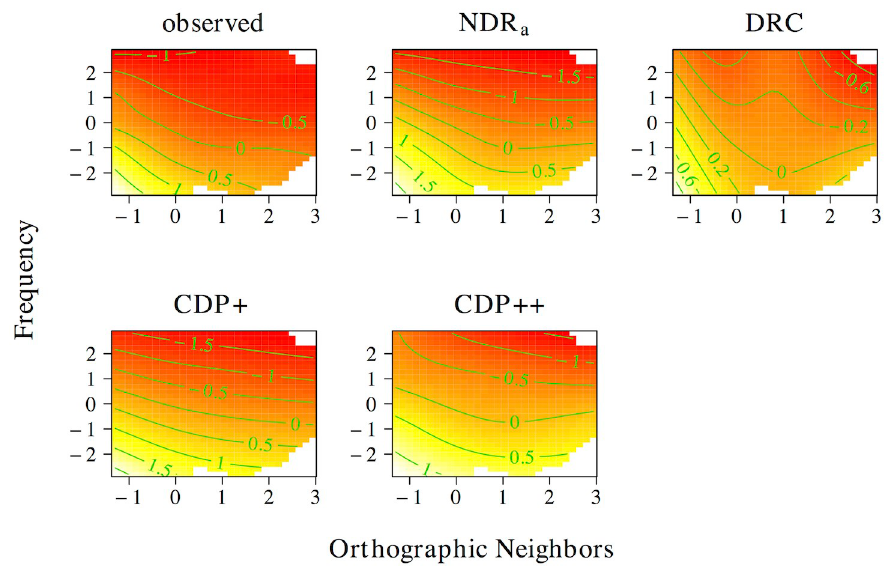
Fig 11. Frequency by neighborhood density interaction. The interaction of frequency with orthographic neighborhood density and phonological neighborhood density in tensor product GAMs.